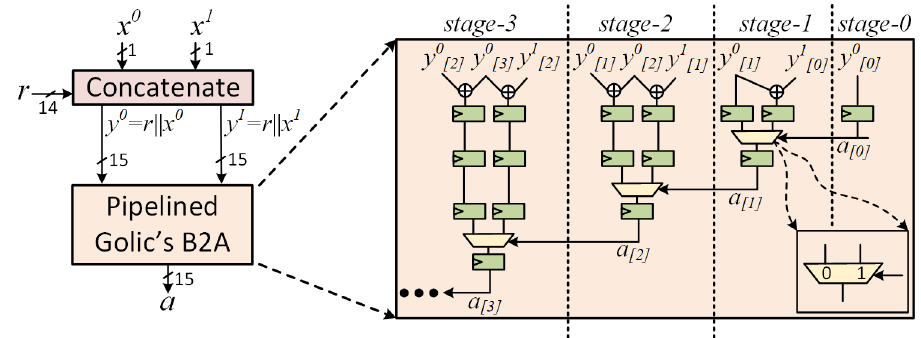
Figure 10: Design of our proposed circuit to process the binary Boolean shares ( x 0 , x 1 ) to x i = a + x 1 . The circuit concatenates the Boolean shares with 14 produce a such that L i random bits and feeds them to a pipelined version of Golic’s Boolean to arithmetic